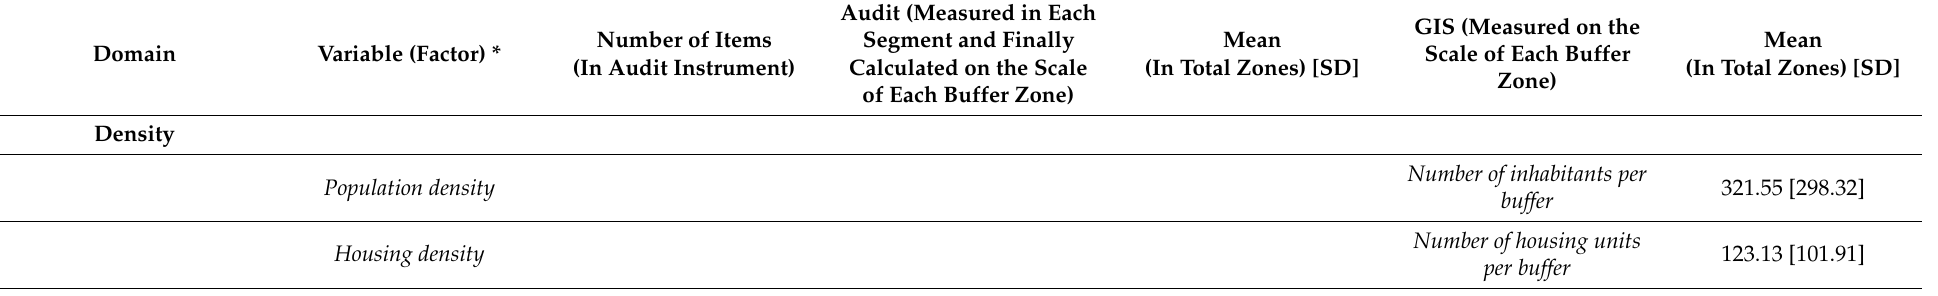
Table 1. The summary measures regarding the built environment through both GIS and audit